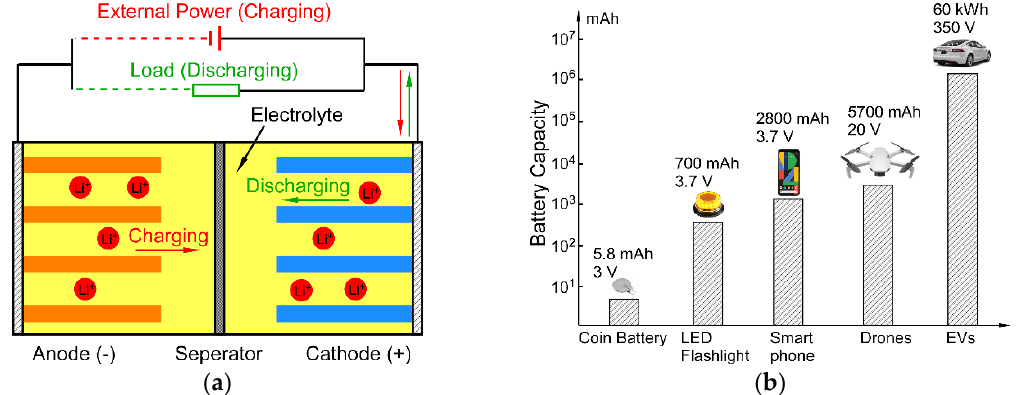
Figure 1. ( a ) Principle of modern lithium-ion battery. ( b ) Typical lithium battery capacity and voltage, versus its application.